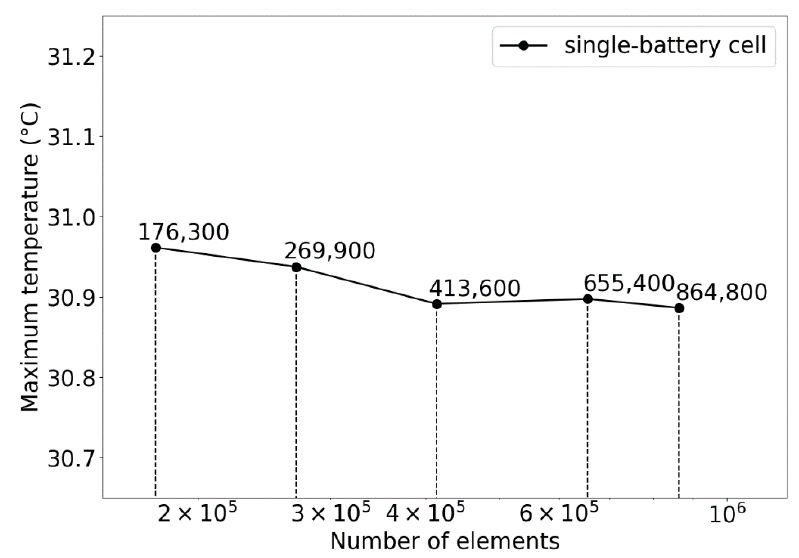
Figure 2. The grid model: ( a ) single-battery cell, and ( b ) battery module inside the fluid domain.